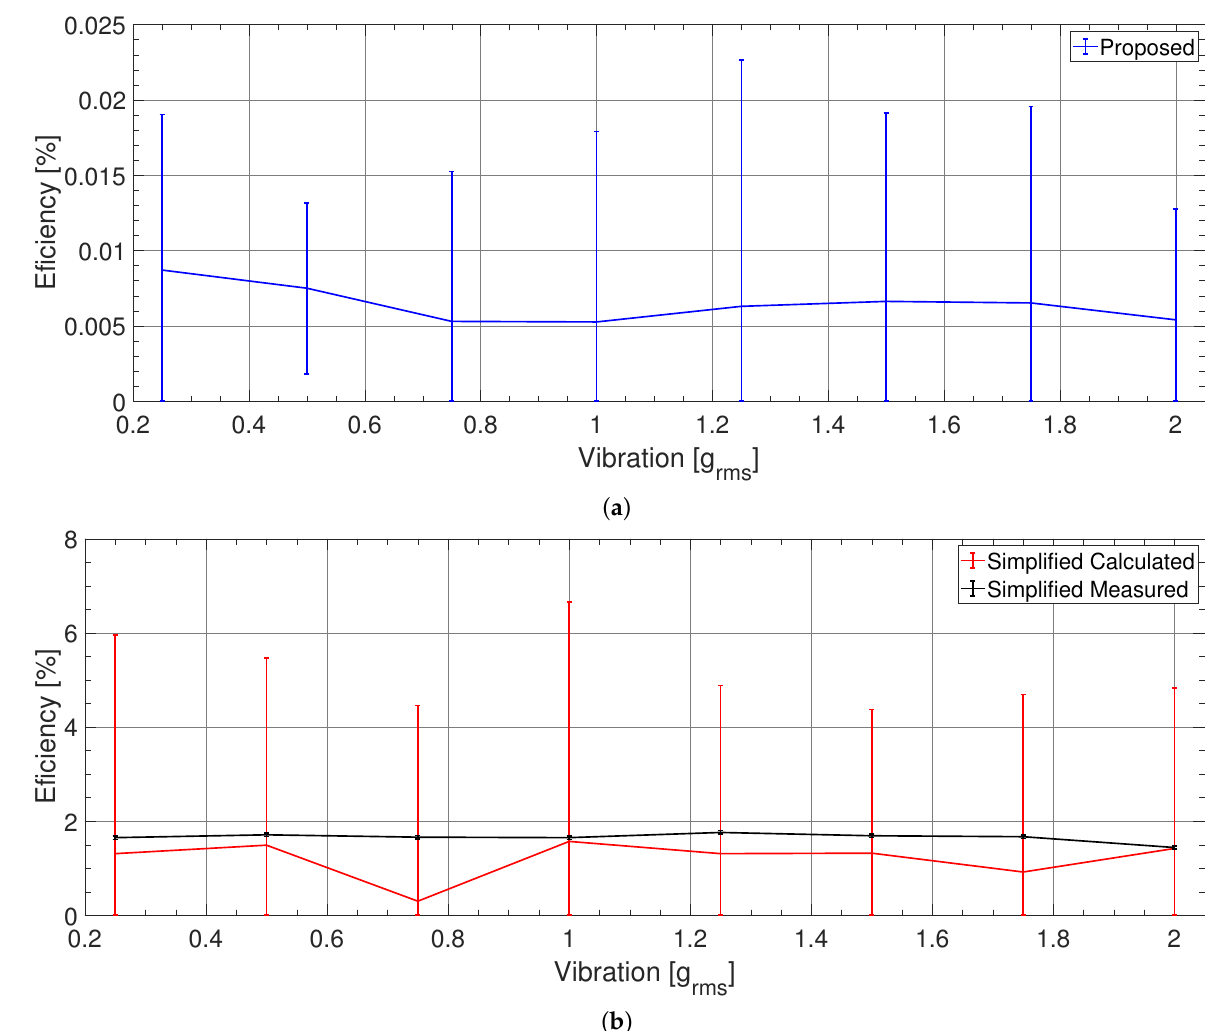
Figure 9. The PVDF PEH: Comparing the efficiency values established via our method (proposed) ( a ) with those calculated from the PEH’s parameters for the optimum condition (simplified calculation) and measured from the PEH mechanical power (simplified measurement) ( b ). The error bars represent the 1 σ interval.